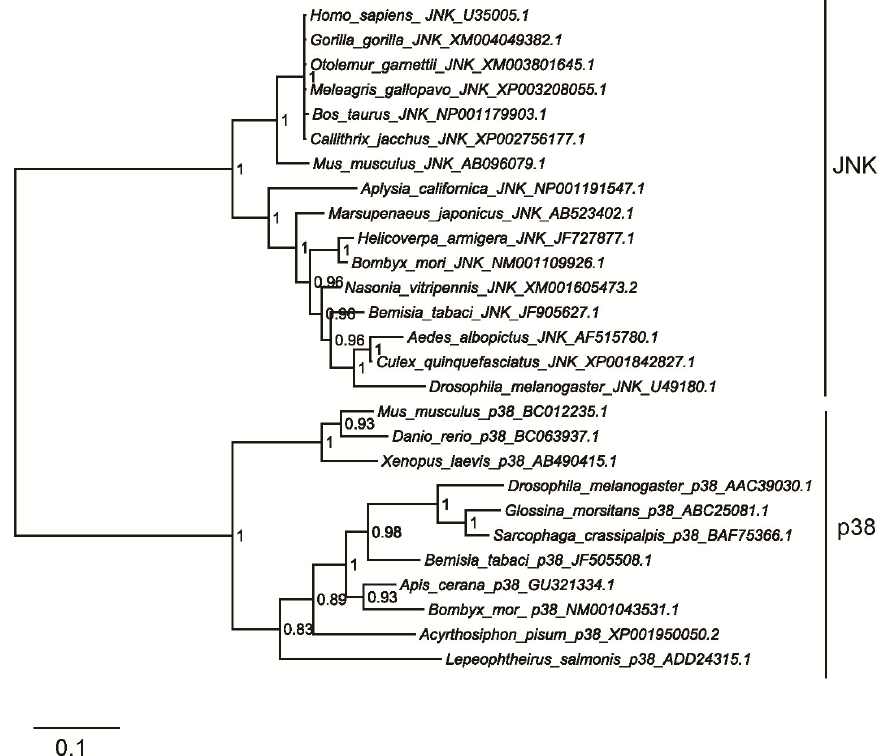
Figure 3. Phylogenetic analysis of JNKs from different species. A phylogenetic analysis was conducted based on a multiple alignment of JNK and p38 amino acid sequences retrieved from the GenBank database. Numbers at the nodes are posterior probability (10,000,000 generations). The scale bar is 0.1.